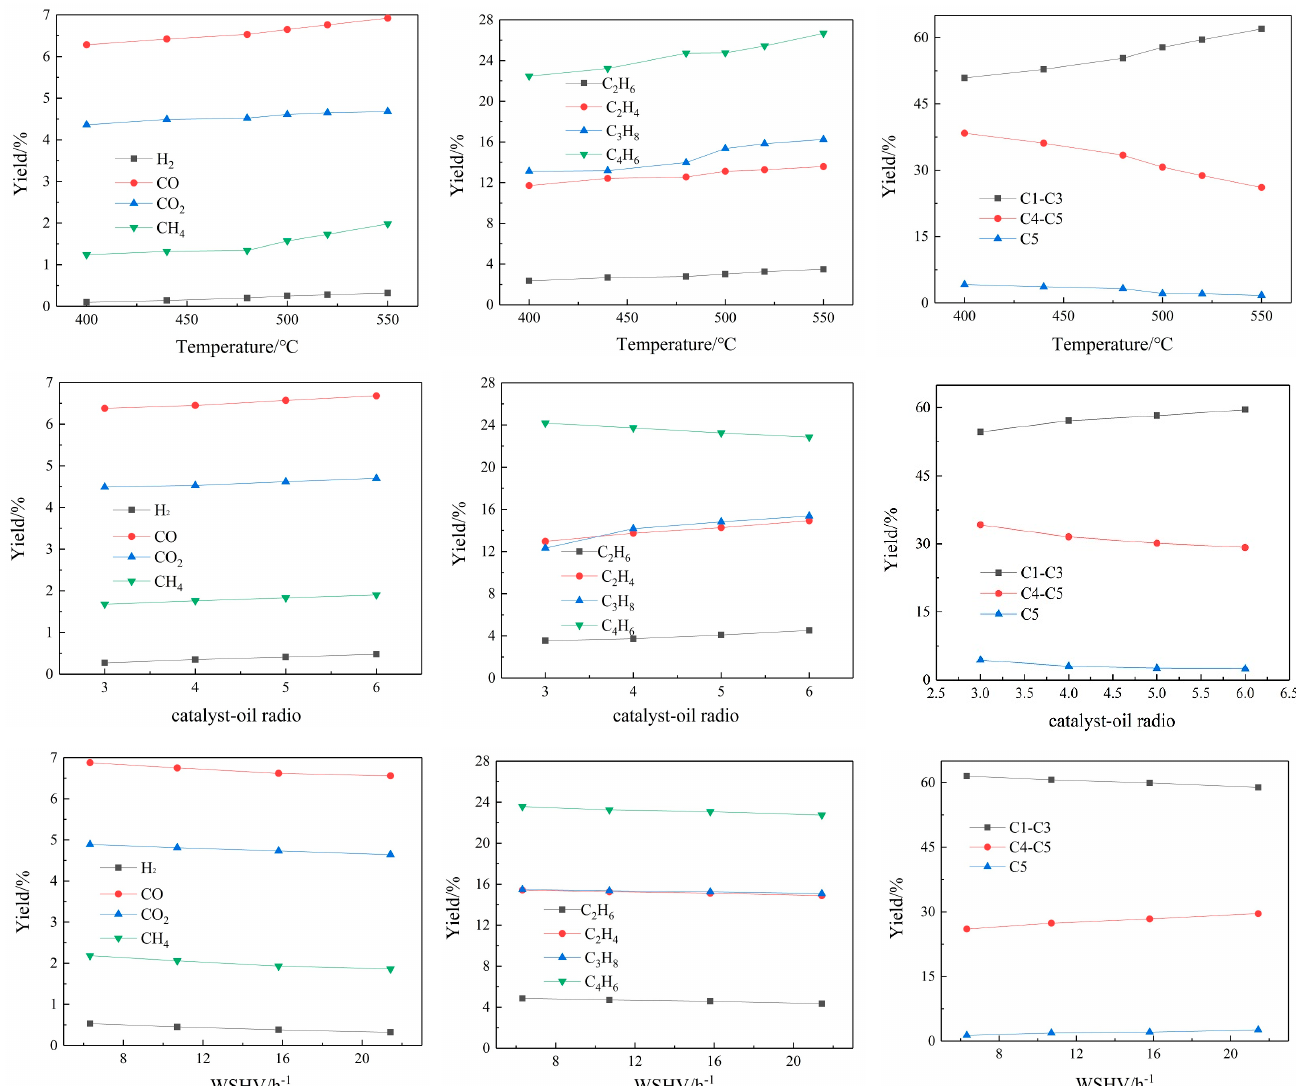
Figure 3. FCC gas yield of waste cooking oil in different process conditions.